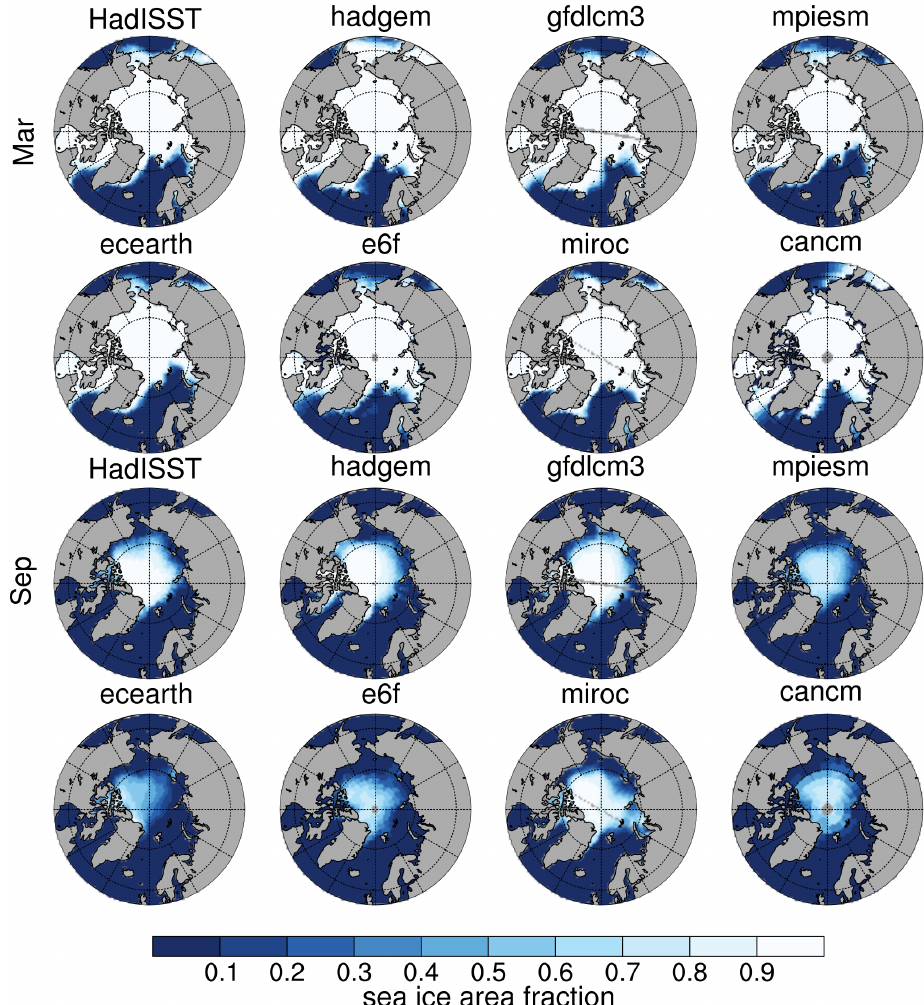
Figure 2. Average sea ice concentration in present-day model control simulations and from HadISST (1983–2012) (Rayner et al.,